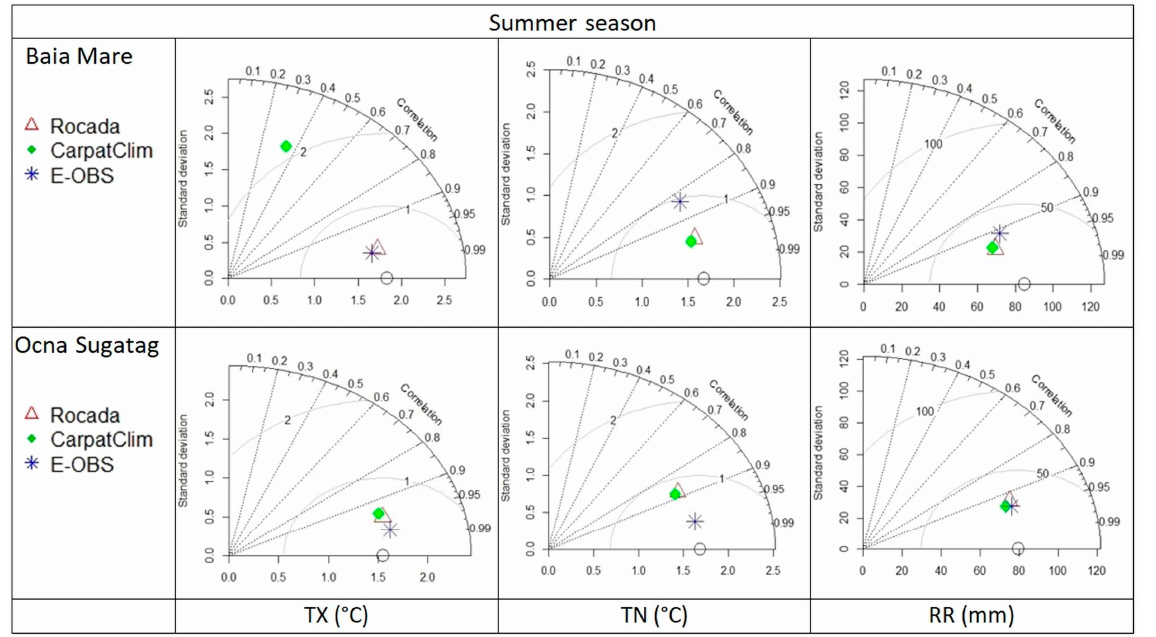
Figure 9. Taylor diagrams for summer (TX, TN, and RR) at the Ocna Ș ugatag and Baia Mare weather stations (1961–2010).